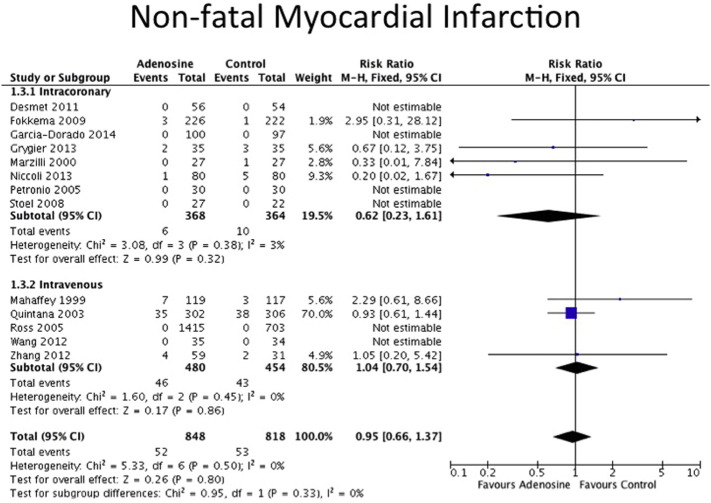
Forest plot for non-fatal MI, adenosine v control.